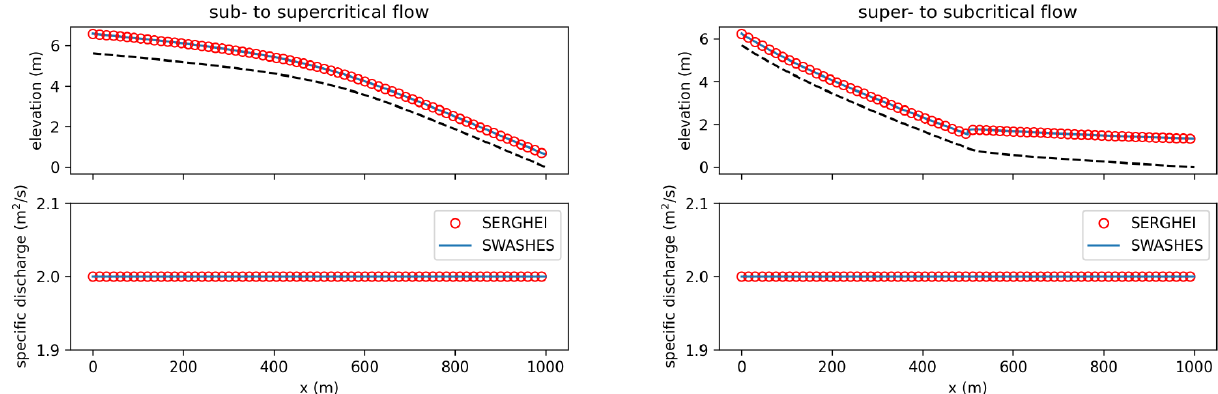
Figure 5. Analytical steady flows: flumes. SERGHEI-SWE captures moving equilibria solutions for two transcritical steady flows. Note that the solution is stable (no oscillations) and well-balanced (discharge remains constant along the flume).